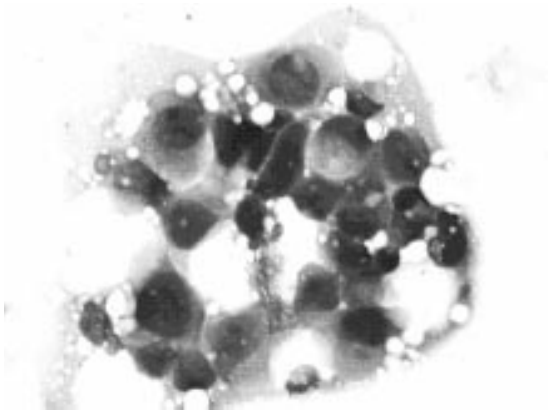
Fig. 1. Cluster of ductal carcinoma cells MG stain; 20 (cid:2) 3-chip cam- era JPG compression